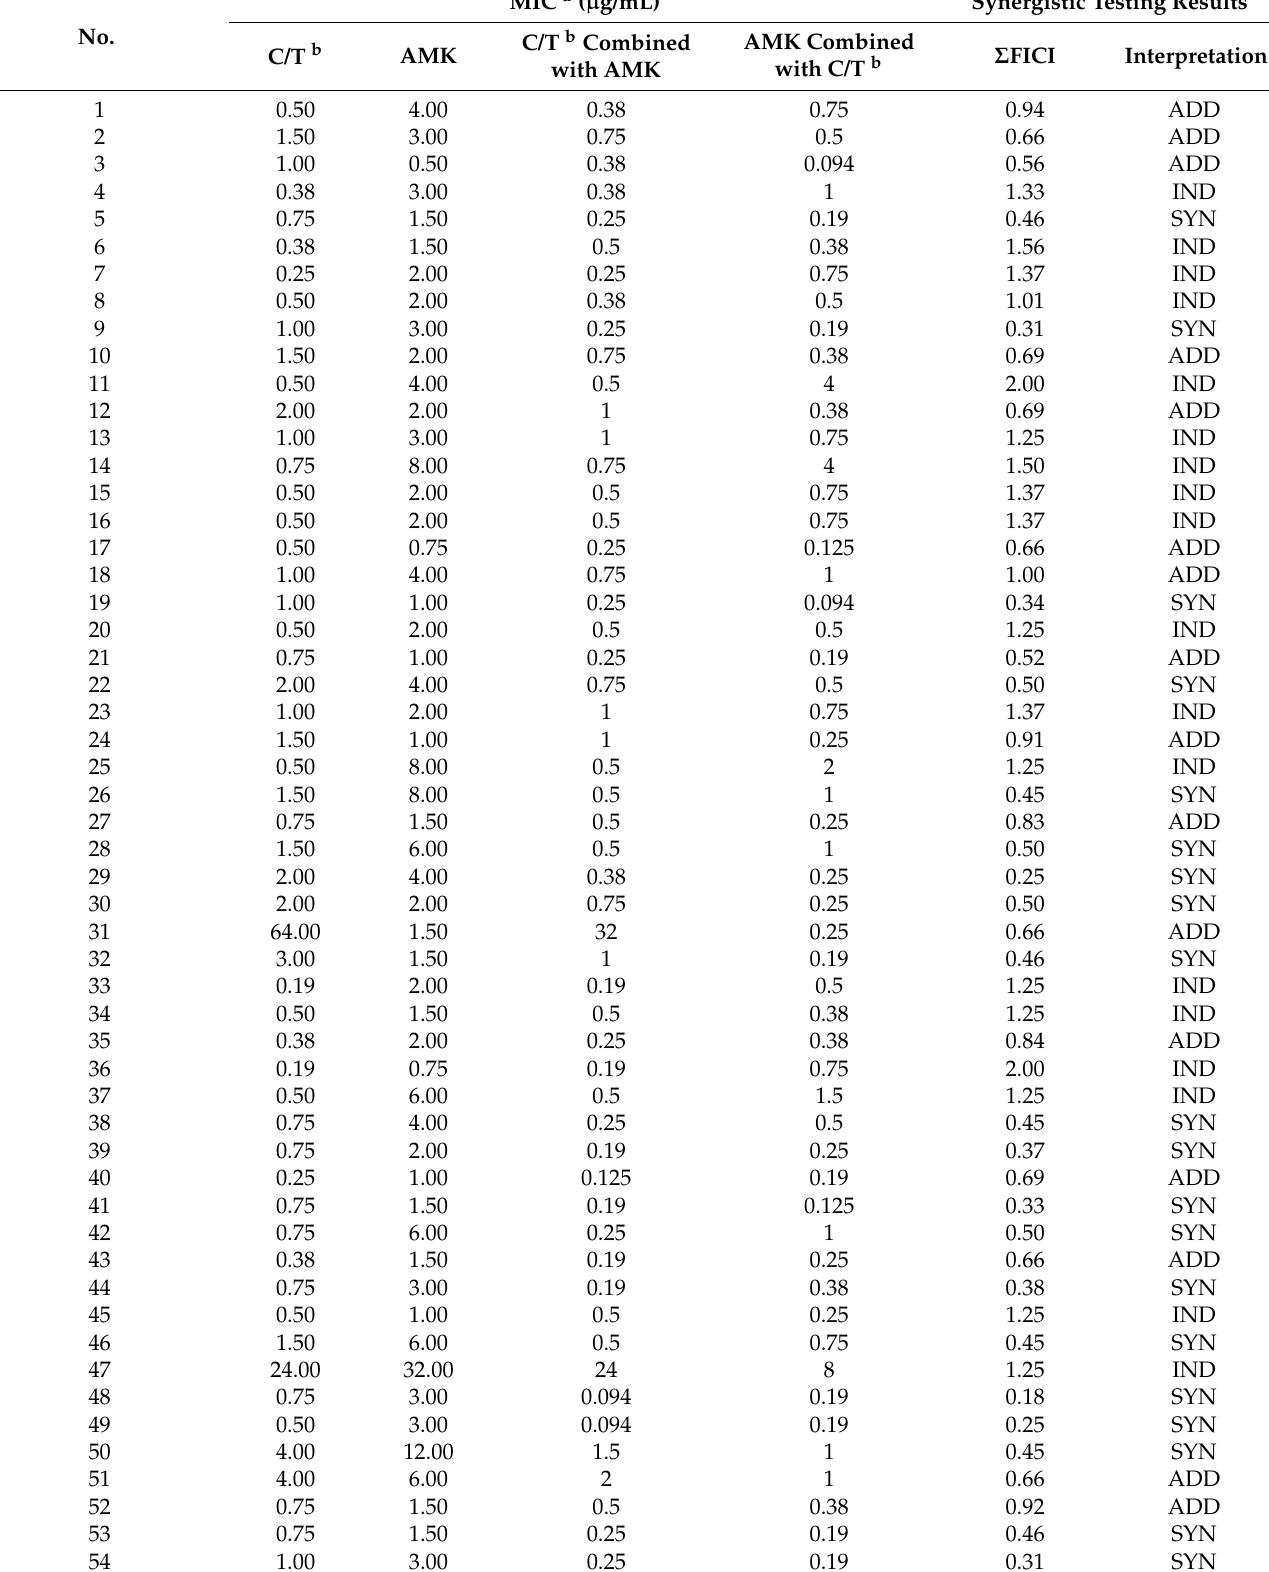
Table 2. E-test results of antibiotic susceptibility to ceftolozane/tazobactam (C/T) ( n = 66) and synergy testing of C/T with amikacin ( n = 60) for all carbapenem-resistant Pseudomonas aeruginosa (CRPA)